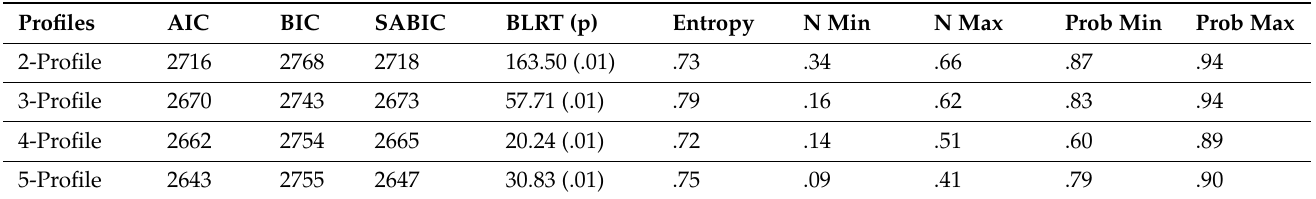
Table 4. Model Fit Indices, Class Size, and Class Probabilities for AMPD-Only Latent Profile Mem- bership.